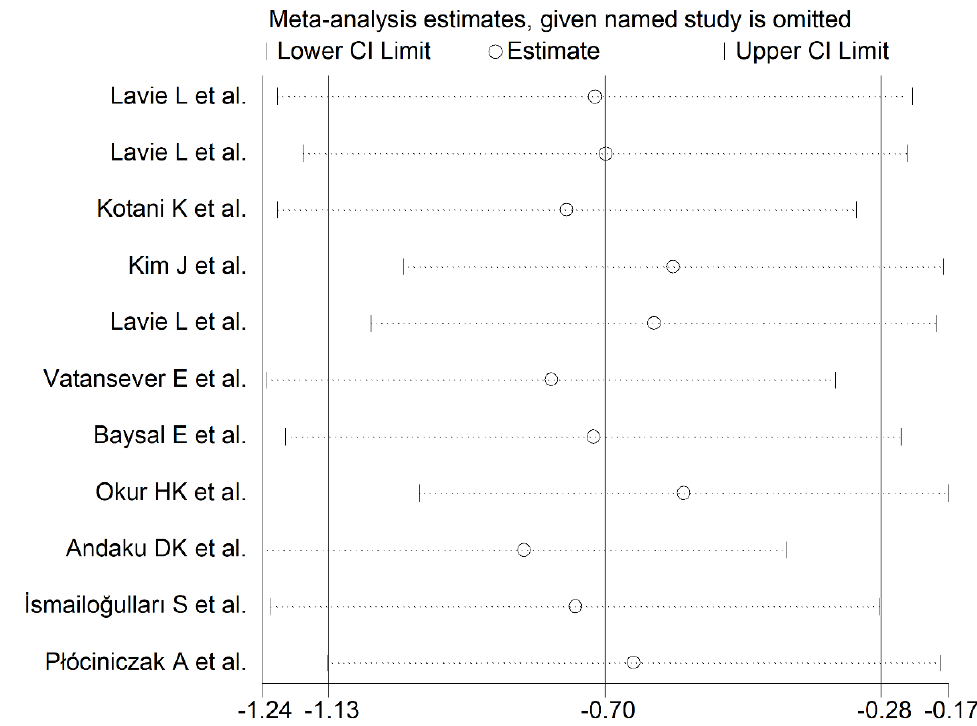
Figure 3. Sensitivity analysis of the association between serum PON-1 concentrations and OSA. For each study, the shown effect size (hollow circles) corresponds to an overall effect size computed from a meta-analysis excluding that study.